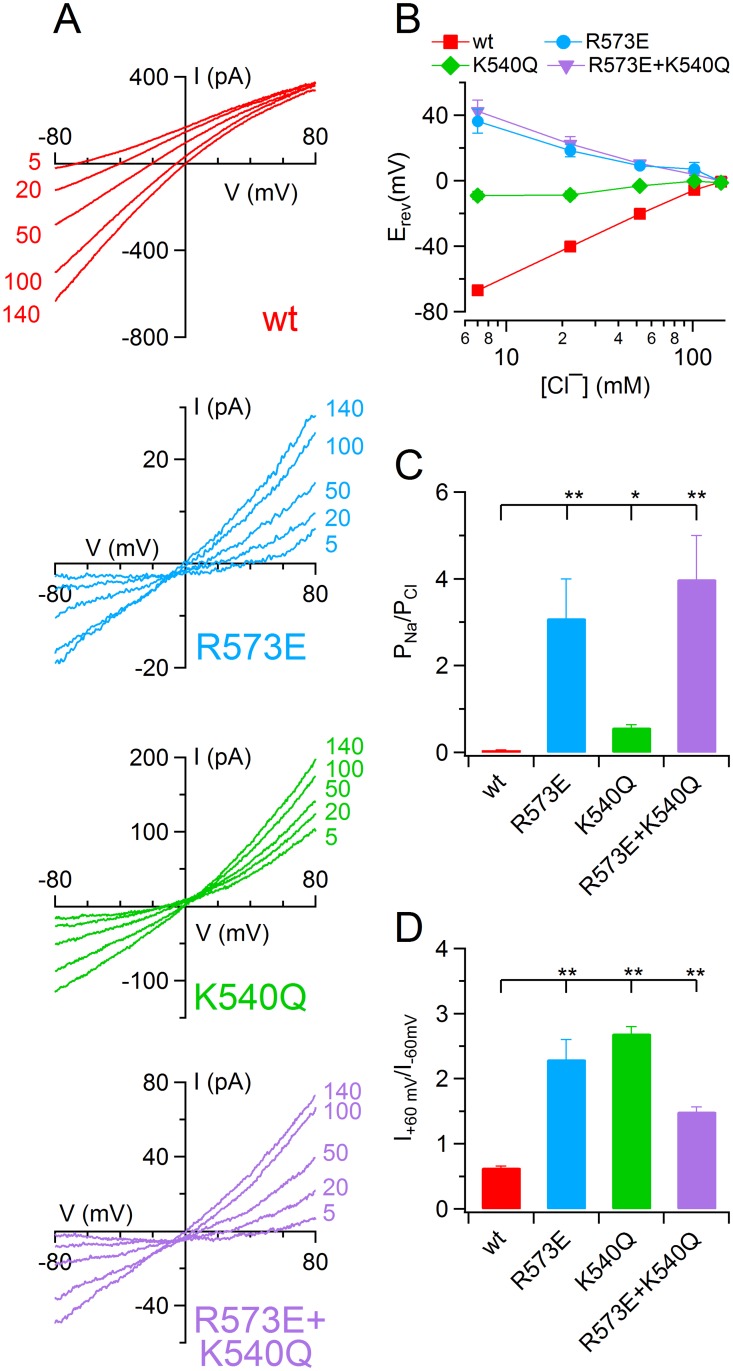
Intracellular sodium permeability in TMEM16B wt and mutant channels.An inside-out patch expressing TMEM16B wt or the indicated mutants was exposed to different cytoplasmatic [NaCl] and the IV relation was determined by a voltage ramp from -100 to +100 mV. The current was activated by 1 mM CaCl2. Leakage currents measured in 0 Ca2+ were subtracted. (B) Average Erev corrected for liquid junction potential was plotted versus [Cl−]i for TMEM16B wt and mutant channels (n = 5–6). (C) Mean permeability ratio between Na+ and Cl− (PNa/PCl) in TMEM16B wt and mutant channels calculated with Goldman-Hodgkin-Katz equation from recordings with 20 mM [NaCl]i (n = 6). (D) Ratios between the currents measured at +60 and -60 mV with symmetrical 140 NaCl solutions for TMEM16B wt and mutant channels (n = 7–12; *p<0.05 **p<0.01 Dunn test after Kruskal Wallis test).